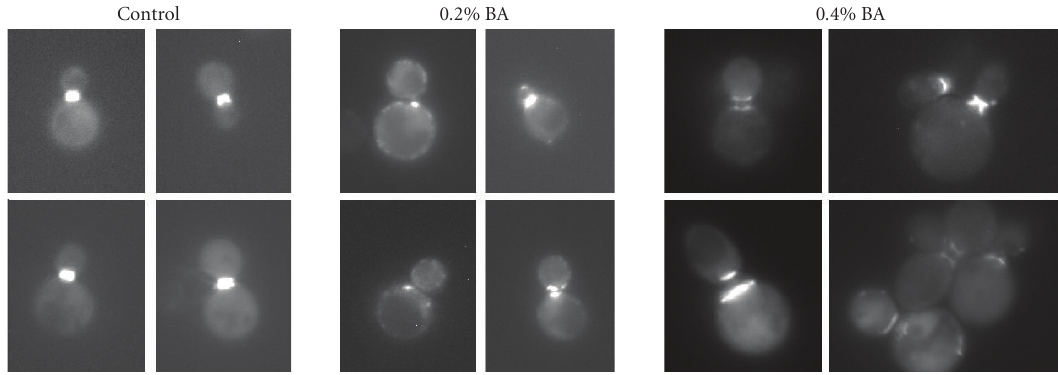
Figure 3: Appearance of septin (Cdc3-GFP) rings in BA-treated cells. Starting at a BA concentration of 0.2% and worsening at 0.4%, septin rings show irregular thickness and wide spacing between the mother and the daughter-side rings. BA also induces ectopic localization of septin patches